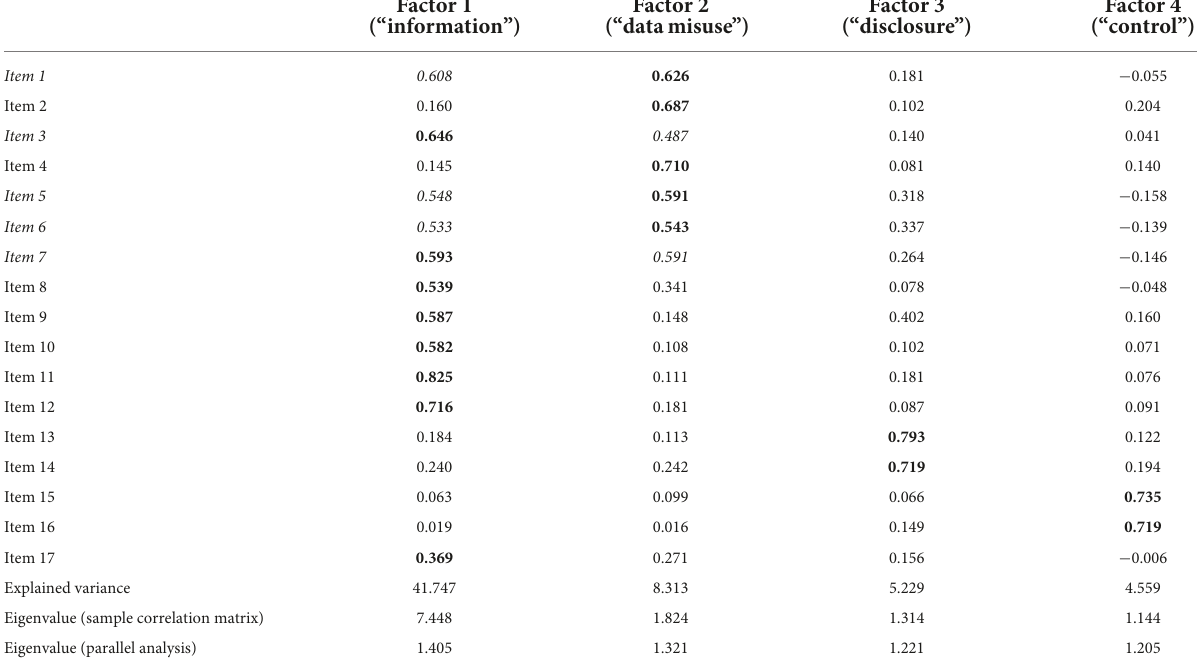
TABLE 3 Results of the exploratory factor analysis with varimax rotation of the app information privacy concerns scale ( N = 349).